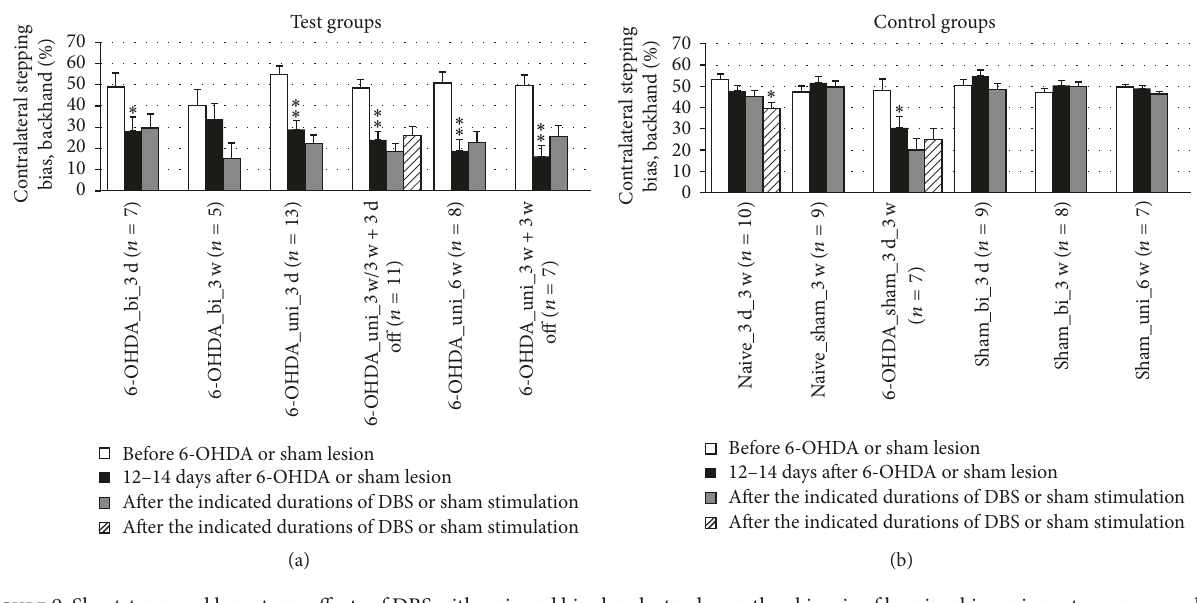
Figure 9: Short-term and long-term effects of DBS with uni- and bipolar electrodes on the akinesia of hemiparkinsonian rats as measured by forced sidestepping of the forepaws in the backhand direction in the stepping tests. (a) and (b) refer to test groups and controls, respectively. Different column patterns indicate different times of behavioral testing; white: before 6-OHDA or sham lesion; black: 12–14 days after 6- OHDA or sham lesion; gray and hatched: after the durations of DBS or sham stimulation indicated in the group labels. For experimental details see Table 1. Significance levels are indicated with asterisks as follows: ∗∗ 𝑝 ≤ 0.01 , ∗ 𝑝 ≤ 0.05 , b (borderline): 0.05 < 𝑝 ≤ 0.08 according to one-way ANOVA. Asterisks above black columns refer to white columns; all others refer to black